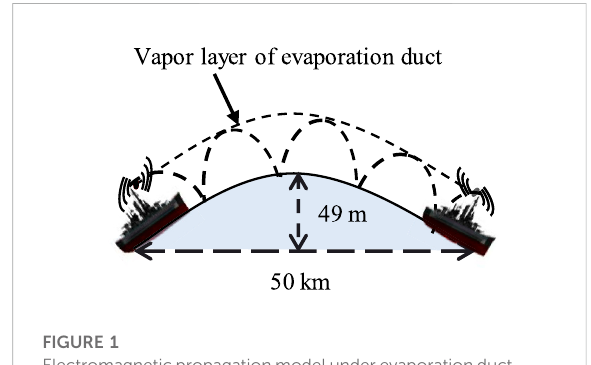
FIGURE 1 Electromagnetic propagationmodel